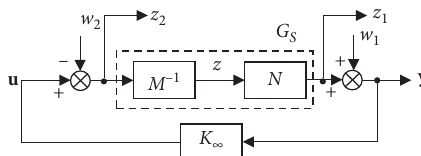
Figure 5: Structure diagram of a two-input two-output